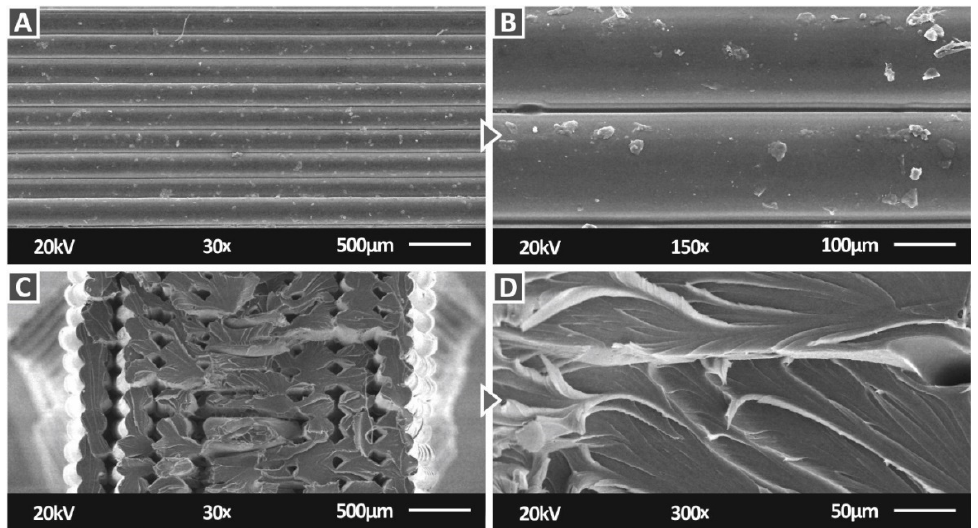
Figure 13. SEM images of the pure PC: ( A ) side surface at 30×, ( B ) side surface at 150×, ( C ) fracture surface at 30×, and ( D ) fracture surface at 300×.